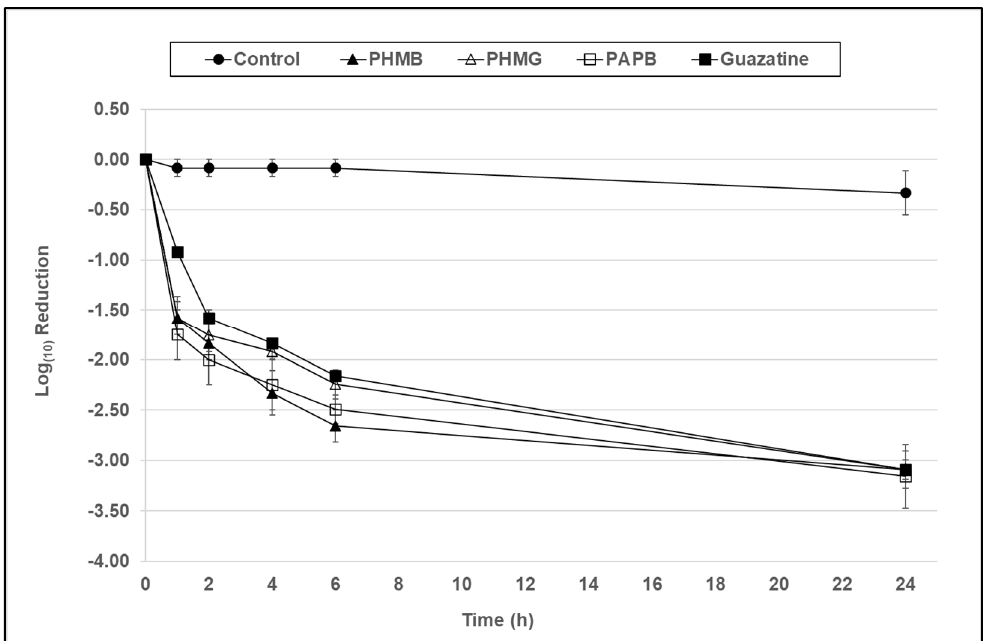
Figure 1. The antimicrobial activity of PHMB, PHMG, PAPB, and guazatine against A. polyphaga (ATCC 30461) trophozoites over a 24 h period at a concentration of 7.8 µg/mL formulated in a contact lens base solution. Error bars show the standard error of the mean (SEM) from triplicate experiments.